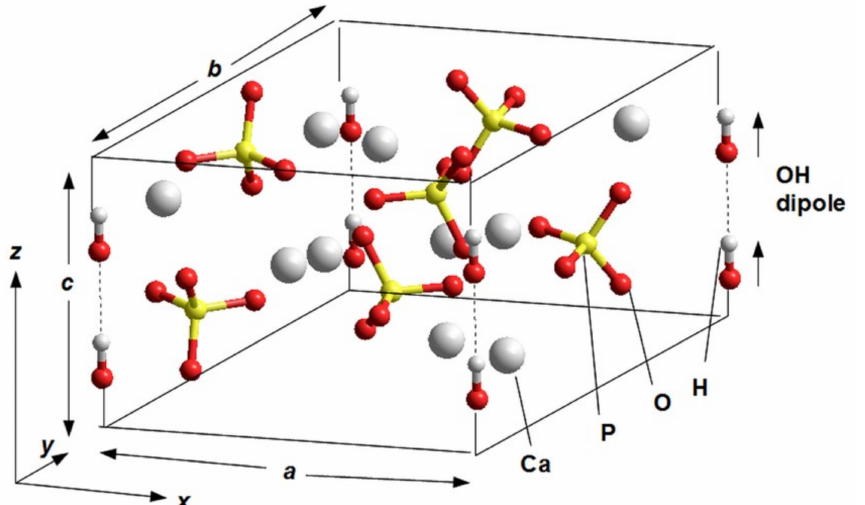
Figure 1. One unit cell model of the Hydroxyapatite (HAP: Ca 10 (PO 4 ) 6 (OH) 2 )– in P6 3 hexagonal phase. All OH groups are oriented in the same direction. They are positioned at the four corners of the unit cell, but only one pair in one corner belongs to this unit cell, the other three pairs belonging to neighboring unit cells (e.g., one OH per unit cell). It also shows the axes of the Cartesian coordinates x, y, z and unit cell parameters a, b, c . (Adapted with permission from ref. [5]; IOP Publishing,